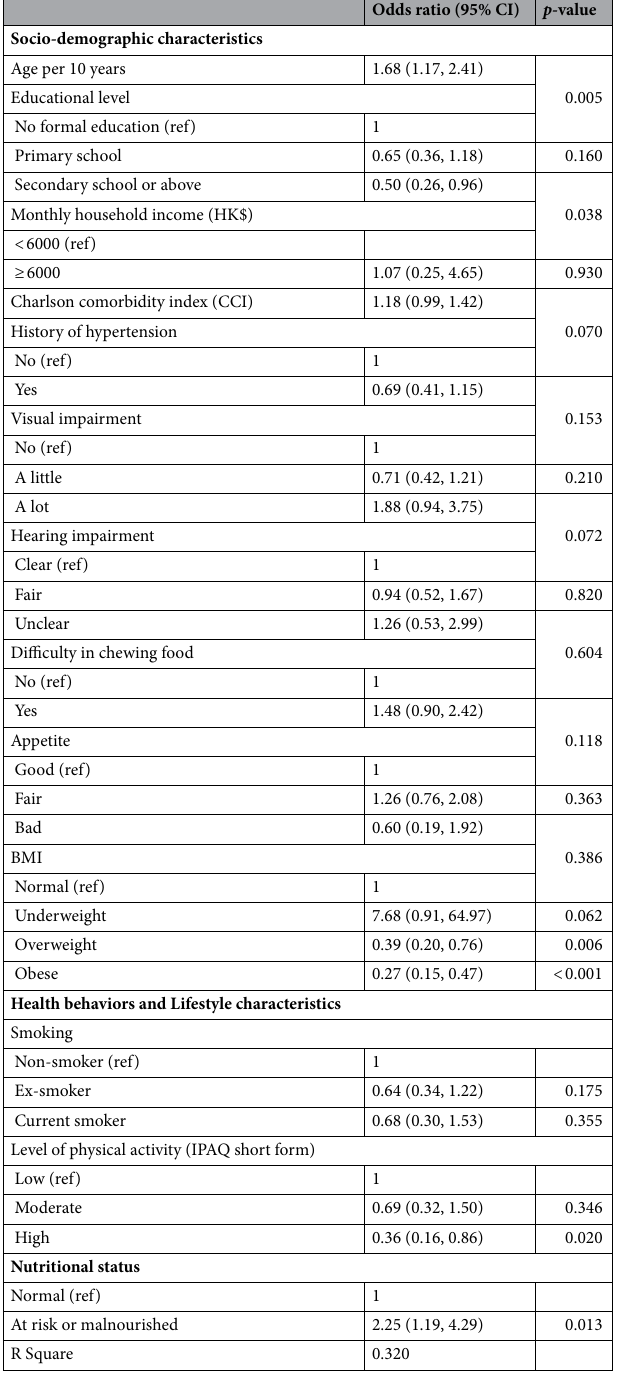
Table 3. Factors associated with risk of sarcopenia estimated by multivariable ordinal logistic regression analysis (N =